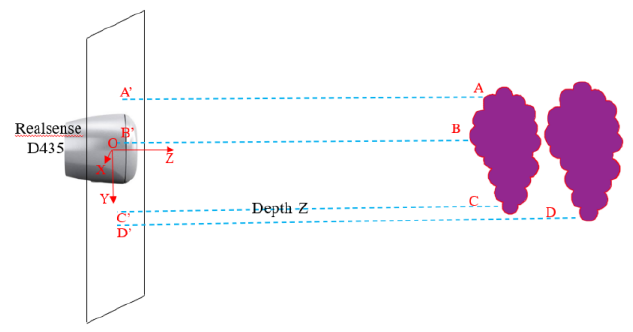
Figure 2. The side view of the overlapping grape clusters.